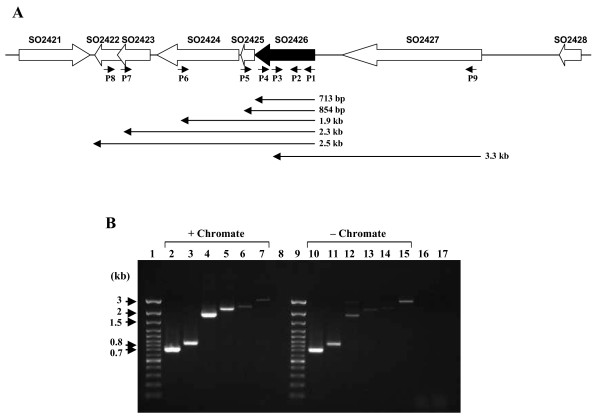
Structural organization of the S. oneidensis MR-1 so2426 locus. (A) Schematic representation of the so2426 gene region. ORFs located upstream and downstream of so2426 (black arrow) are indicated by open arrows, which also indicate the direction of transcription. The deduced proteins of the ORFs flanking so2426 have the following annotations based on the J. Craig Venter Institute's Comprehensive Microbial Resource : SO2421 is a L-asparaginase I; SO2422 is a conserved hypothetical protein; SO2423 is a hypothetical protein; SO2424 is a zinc carboxypeptidase domain protein; SO2425 is a hypothetical protein; SO2426 is a DNA-binding response regulator; SO2427 is a putative TonB-dependent receptor; and SO2428 is a hypothetical protein. The locations of the oligonucleotide primers (P1–P9) used for RT-PCR are shown by the small solid arrows. The expected PCR product sizes for the different primer pairs are given below. (B) Agarose gel (1%) electrophoresis of amplified DNA fragments derived from S. oneidensis MR-1 cDNA templates under conditions of chromate stress or no stress. Lane designations: (1) 100-bp DNA ladder; (2) PCR primer pair P1/P4, (3) P1/P5, (4) P1/P6, (5) P1/P7, (6) P2/P8, (7) P9/P3, (8) blank, (9) 100-bp DNA ladder, (10) P1/P4, (11) P1/P5, (12) P1/P6, (13) P1/P7, (14) P2/P8, (15) P9/P3, (16) chromate-treated total RNA used as the template in PCR amplification with P1/P4 (negative control), and (17) non-stressed total RNA used as the template in PCR amplification with P1/P4 (negative control).